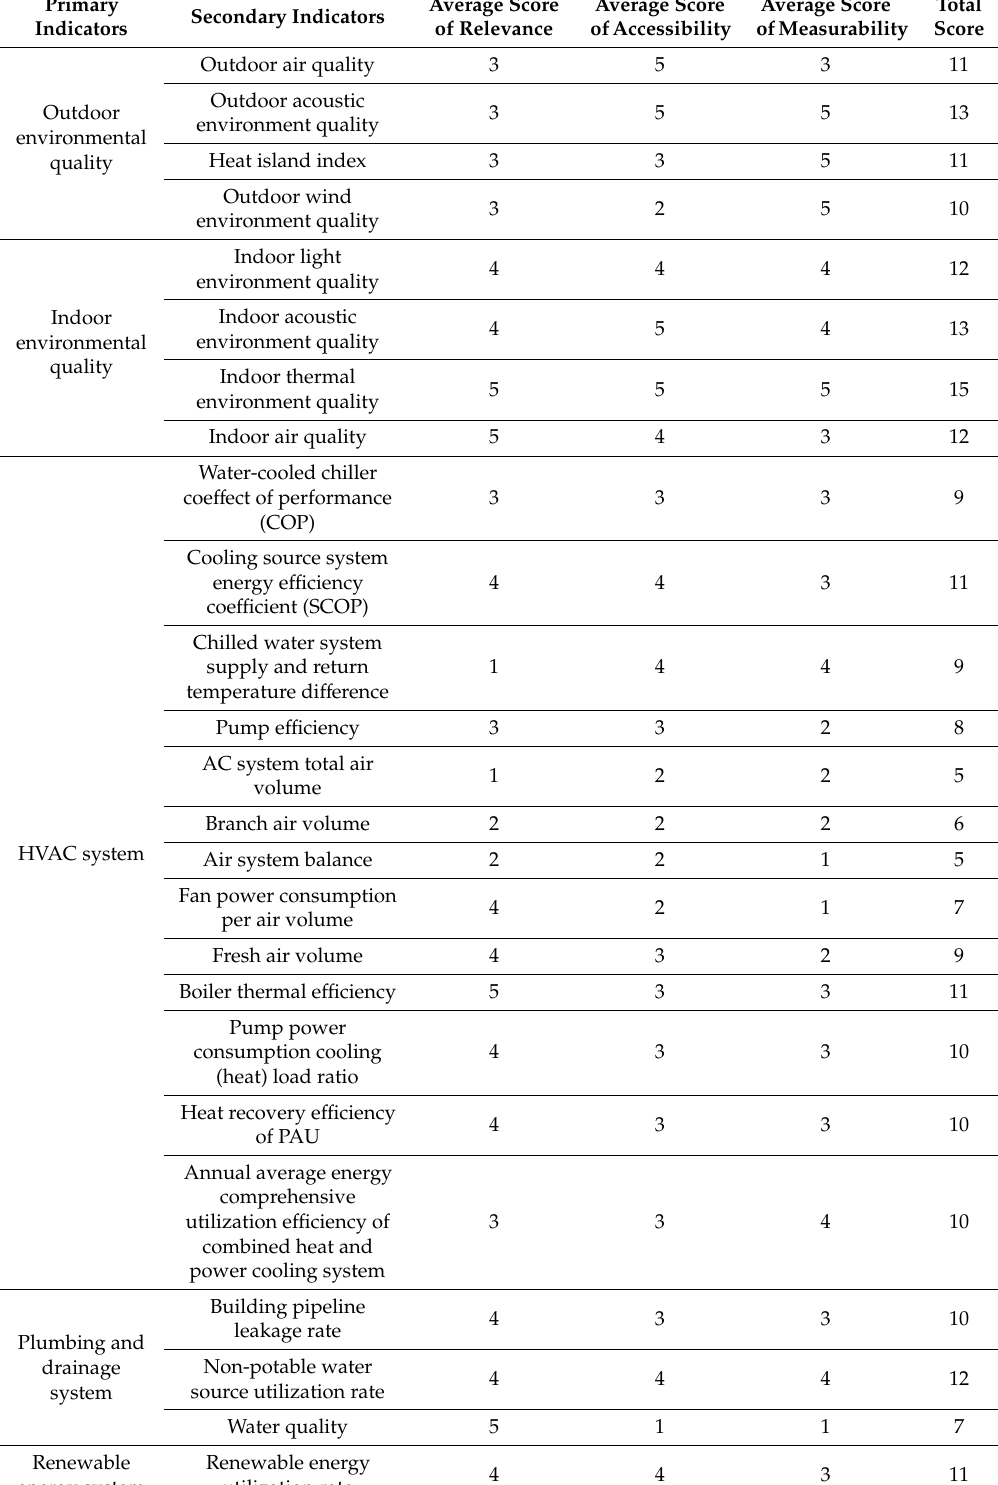
Table 11. Average score results (round to the nearest integer) of each aspect and total scores for secondary indicators according to twenty green building experts’ knowledge and